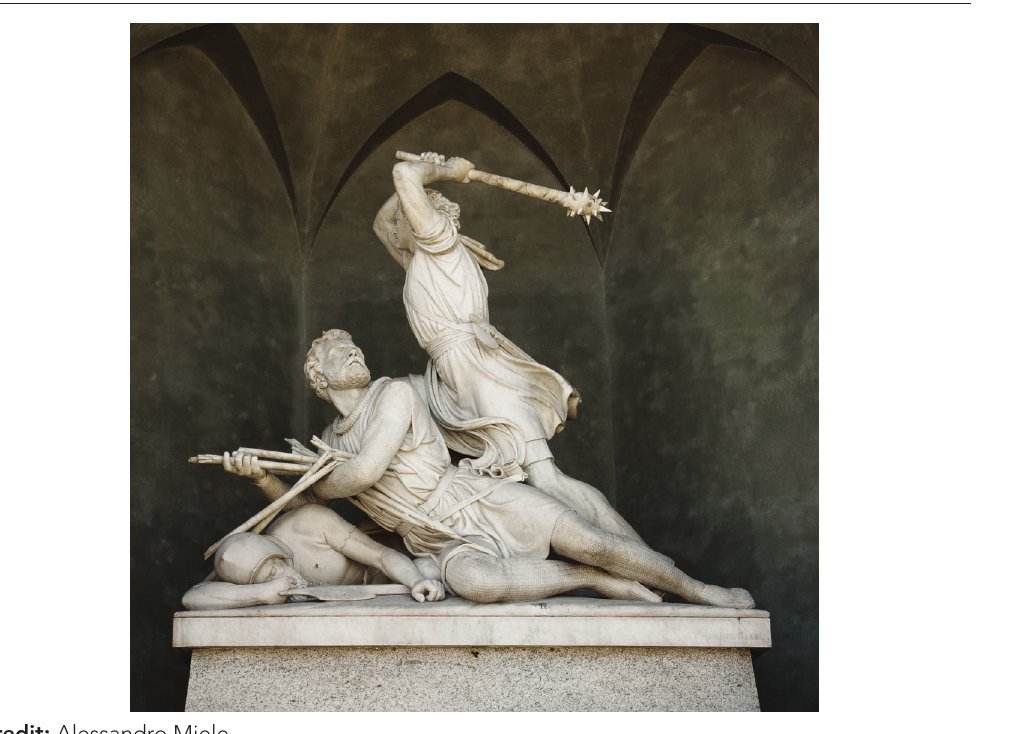
Figure 1: The Winkelried